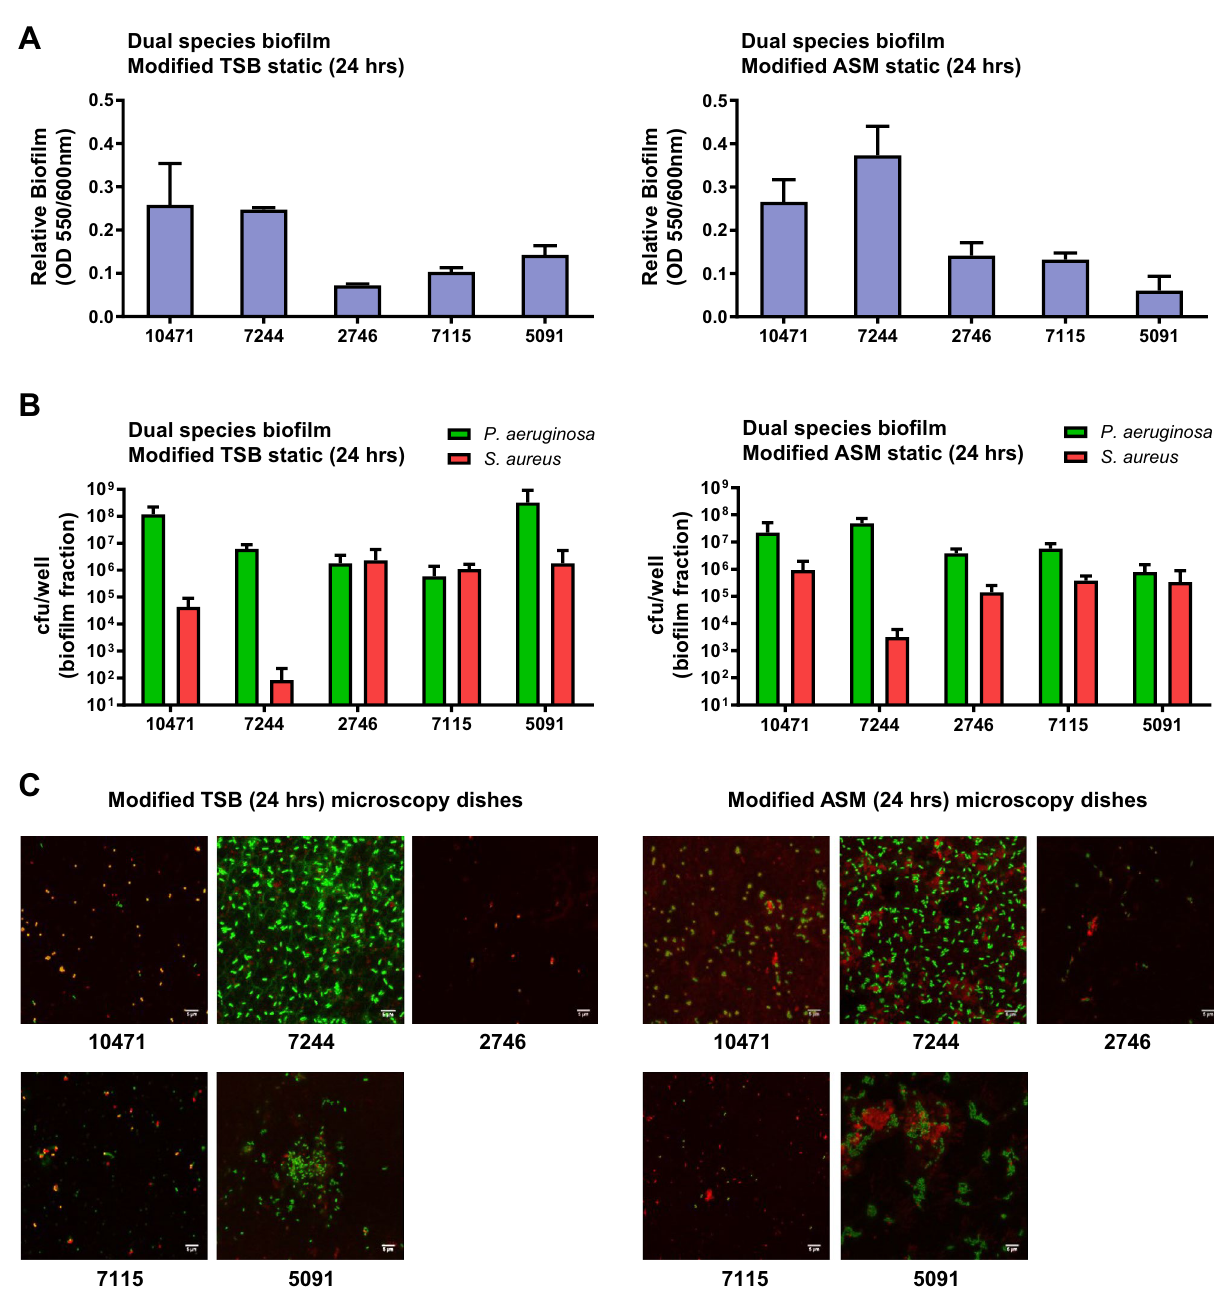
Figure 3. Attachment and microcolony formation in dual species static biofilms of clinical S. aureus and P. aeruginosa . Biofilm biomass measured by crystal violet method ( A ) and population of each bacterium in the mixed biofilm ( B ). Biofilms were grown under static conditions on polystyrene microtiter plates in 0.5X TSB supplemented with 1% glucose or in artificial sputum medium (ASM) mixed 1:1 with 0.5X TSB 1% glucose for 24 h. ( C ) Representative confocal laser scanning microscopy images of co-culture biofilms grown under static conditions on microscopy dishes for 24 h, and stained fluorescently for differentiation between species. Texas Red-X selectively binds to the surface of gram-positive bacteria to fluoresce red, while SYTOX counterstains the Gram negative fixed cells and fluoresces green. Scale bars represent 5 μm. In all experiments bacterial inoculation ratio was 10:1 ( S. aureus : P. aeruginosa ) and error bars indicate standard deviation of three biological replicates. Strain names are according to the origin of the sample (see Tables 1, S1 and